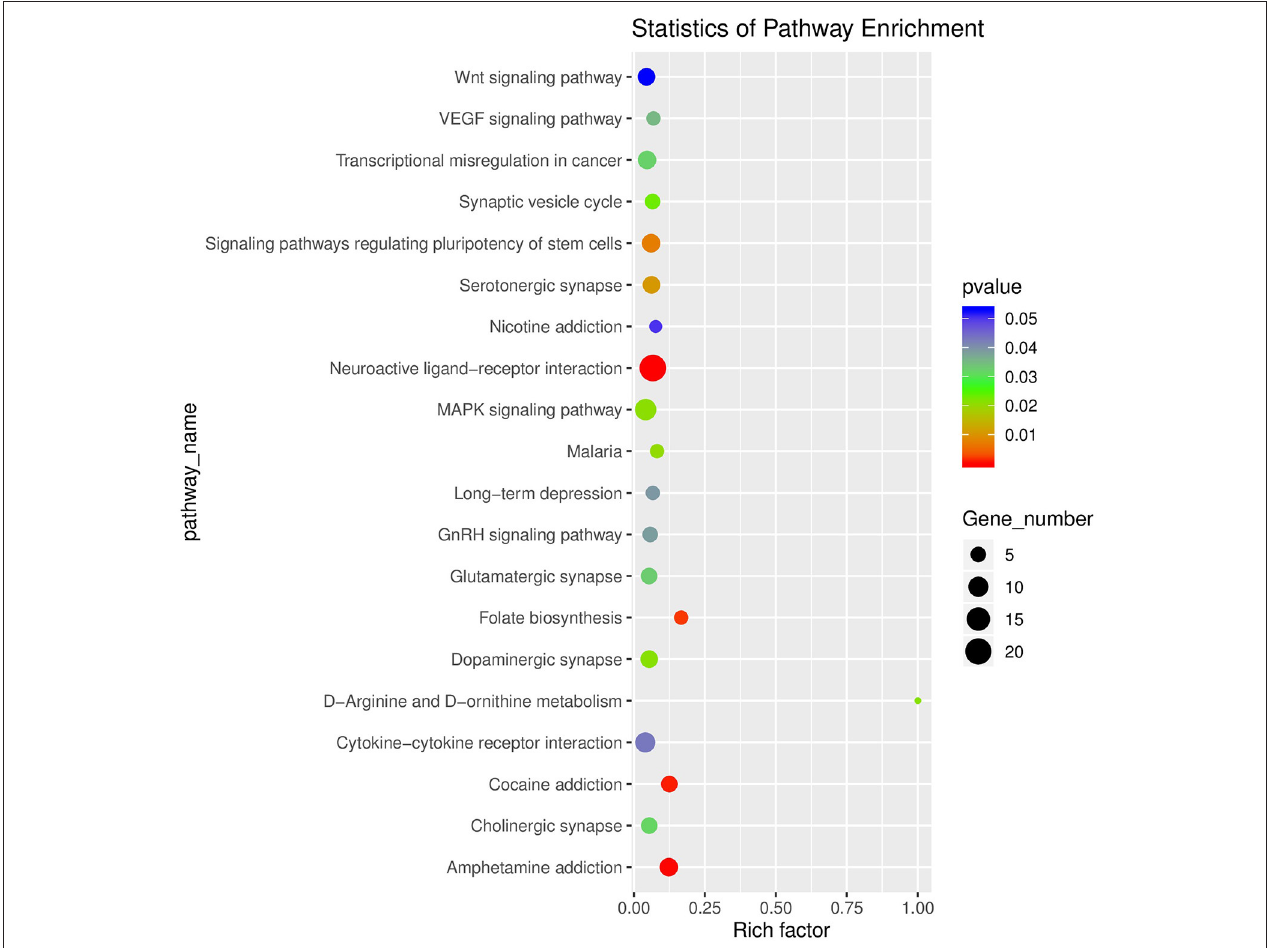
FIGURE 5 | Enrichment diagram of significantly different genes based on a KEGG analysis (top 20). The rich factor referred to the ratio of the number of deferential expressed genes to the total number of genes enriched in a specific category. The size of circles roughly represented the count of deferential expressed genes. The color saturation from blue to red indicated P -value (Student-Newman-Keuls test, n = 3).